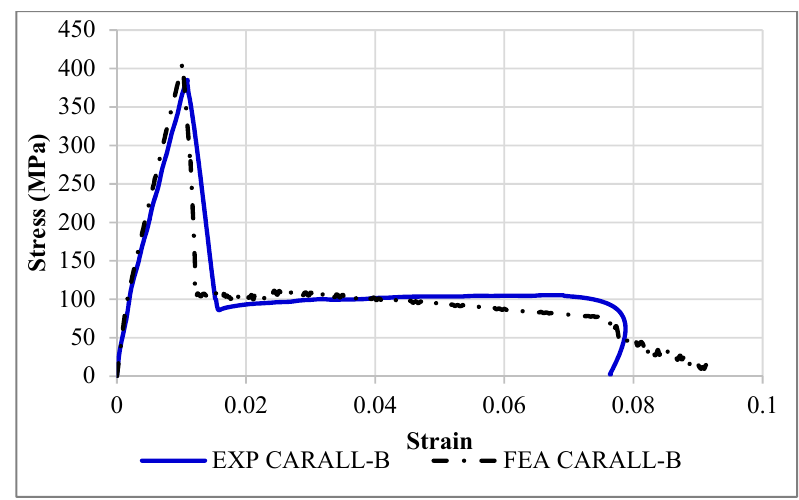
Figure 28. FEA and experimental stress-strain plots for CARALL-B specimens.